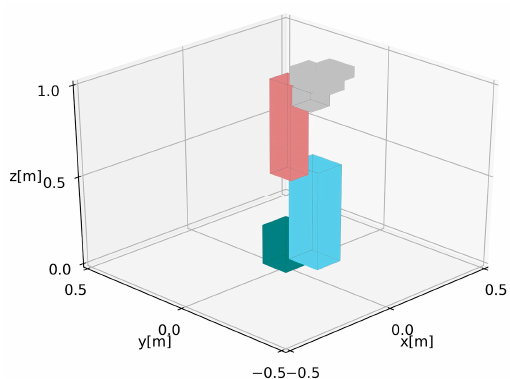
Figure 4. The manipulator covered by the bounding boxes ready to check collision, where the green box is Link 1, the blue box is Link 2, the red box is Link 3, and the gray boxes are the combination of Links 4 to 6.